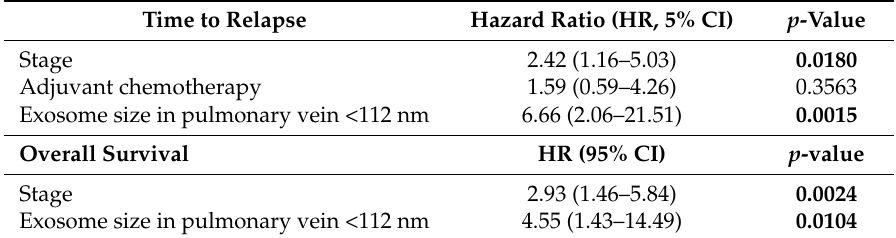
Table 2. Cox multivariate analyses of time to relapse and overall survival. Bold for p < 0.05. Time to